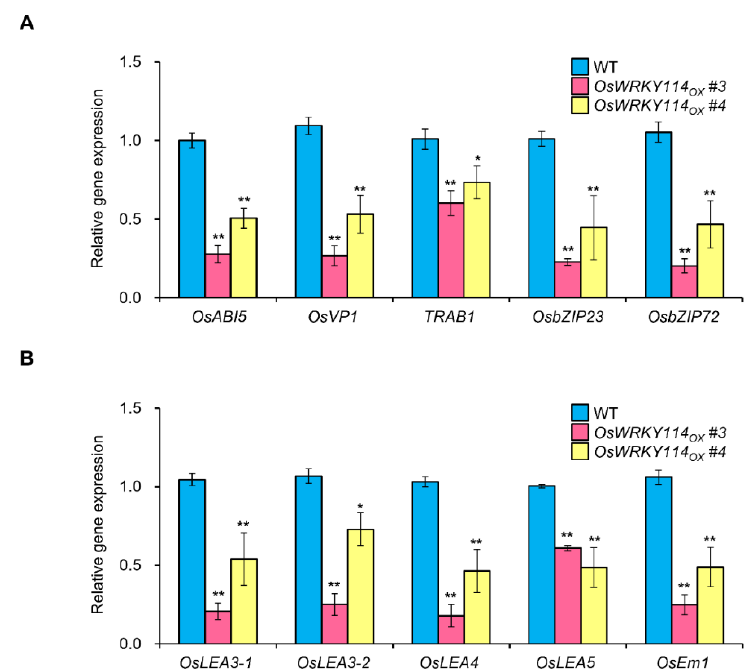
Figure 5. The expressions of various ABA-associated genes are downregulated in OsWRKY114 - overexpressing plants. ( A ) Relative transcript levels of ABA-response genes in 4-week-old rice plants, as determined by RT-qPCR. cDNA was synthesized from total RNA in rice leaves. OsActin was used as an internal control. Data are shown as means ± SD. * p < 0.05, ** p < 0.01, determined by t -test relative to wild-type sample. ( B ) Relative transcript levels of ABA-related genes in 4-week-old rice plants, as determined by RT-qPCR. cDNA was synthesized from total RNA in rice leaves. OsActin was used as an internal control. Data are shown as means ± SD. * p < 0.05, ** p < 0.01, determined by t -test relative to wild-type sample.